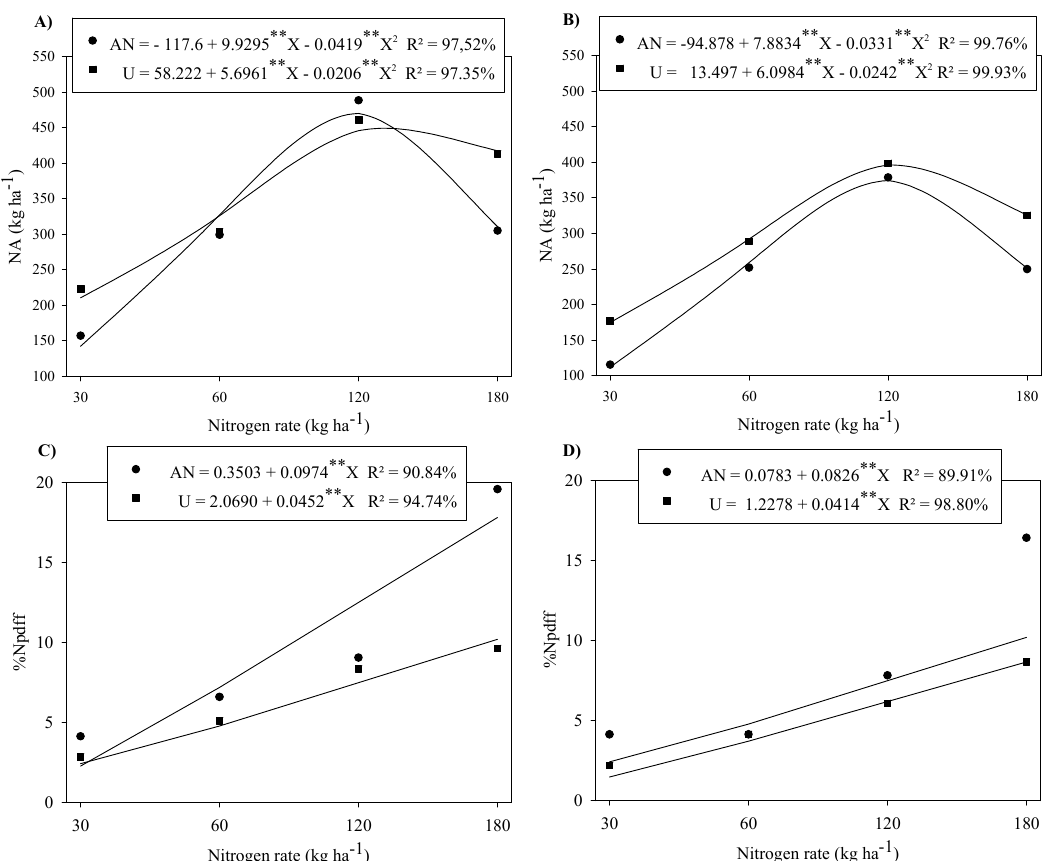
Figure 2. Accumulated nitrogen (NA) and percentage of N in sugarcane plant derived from fertilizer (%Npdff), stalk ( A , C ), and pointer ( B , D ), in the cane plant cycle, as affected by N rate as ammonium nitrate (AN) and urea (U). ** Significant respectively at 1% probability according to test F.